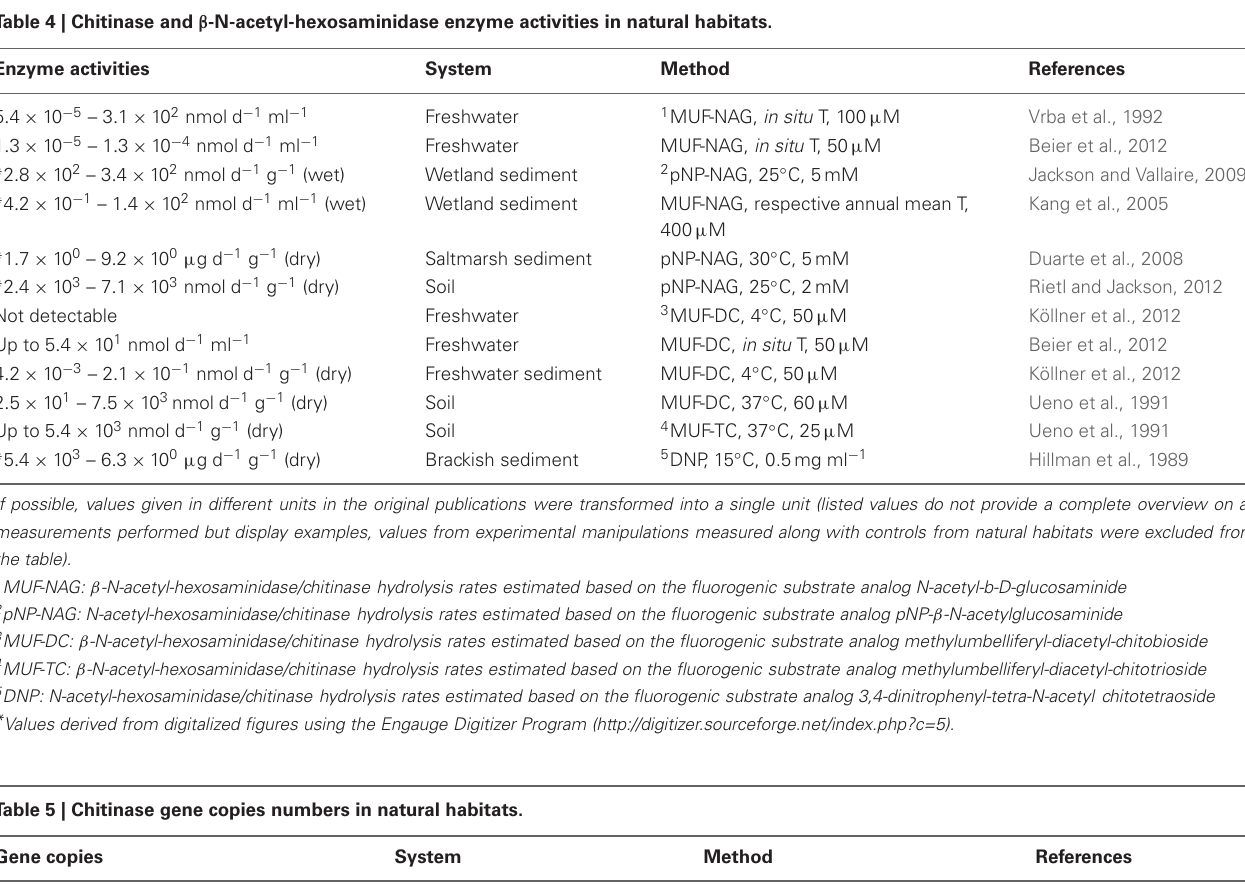
Table 4 | Chitinase and β -N-acetyl-hexosaminidase enzyme activities in natural habitats. Enzyme activities